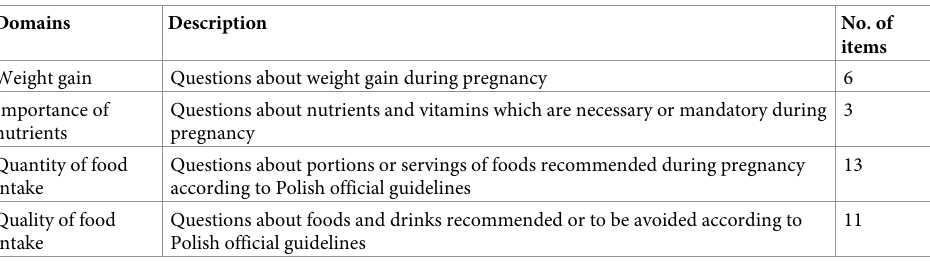
Table 2. Summary of the domains of the